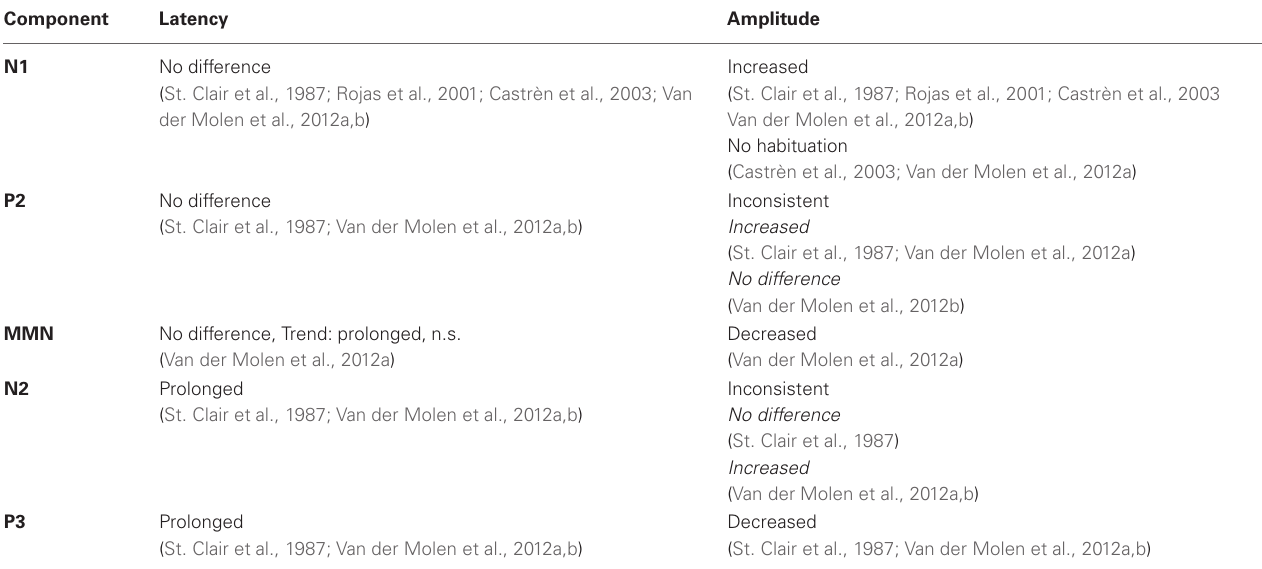
Table 5 | Main ERP component findings in FXS patients compared with healthy controls.